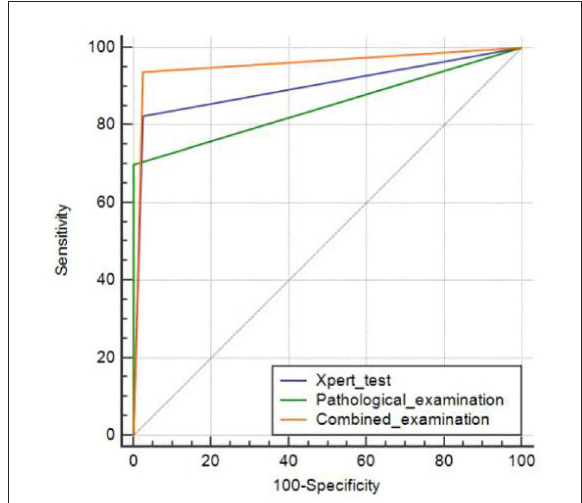
FIGURE2 Areas under the receiver operating characteristic curve plotted to determine the diagnostic values of pathological examination alone, Xpert examination alone, and the combination of the